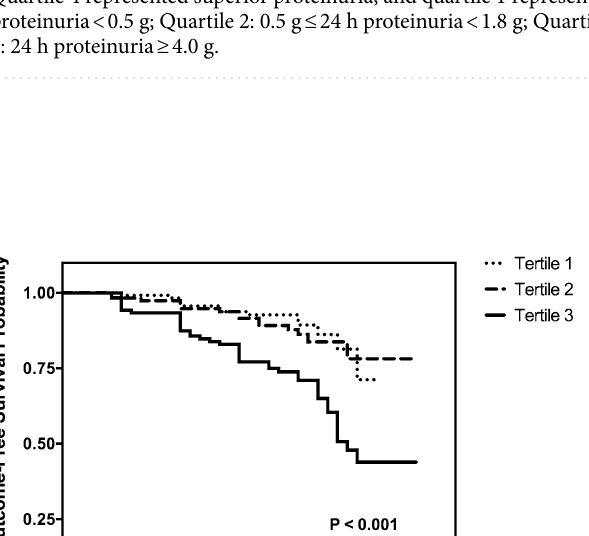
Figure 1. Influence of CKD stage and proteinuria on the lowest nocturnal systolic blood pressure (LNSBP). Quartile 4 represented superior proteinuria, and quartile 1 represented inferior proteinuria. Quartile 1: 24-h